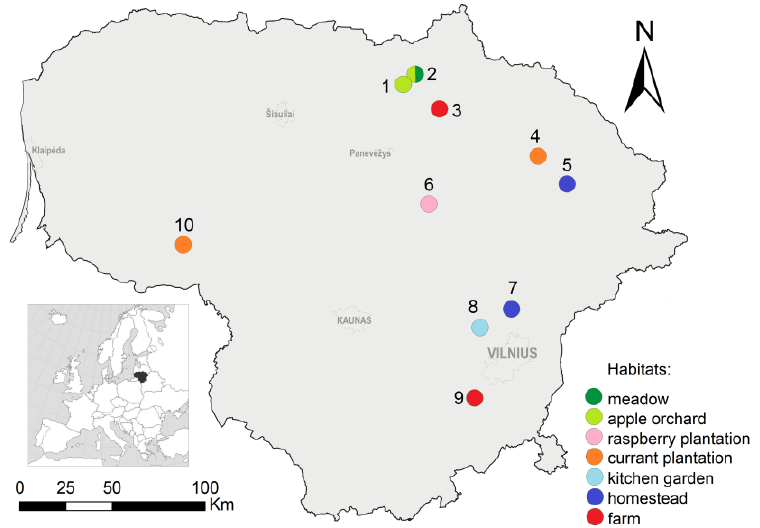
Figure 1. Study sites in Lithuania, 2018–2022. Habitats, in order from natural to most commensal, indicated by colour.